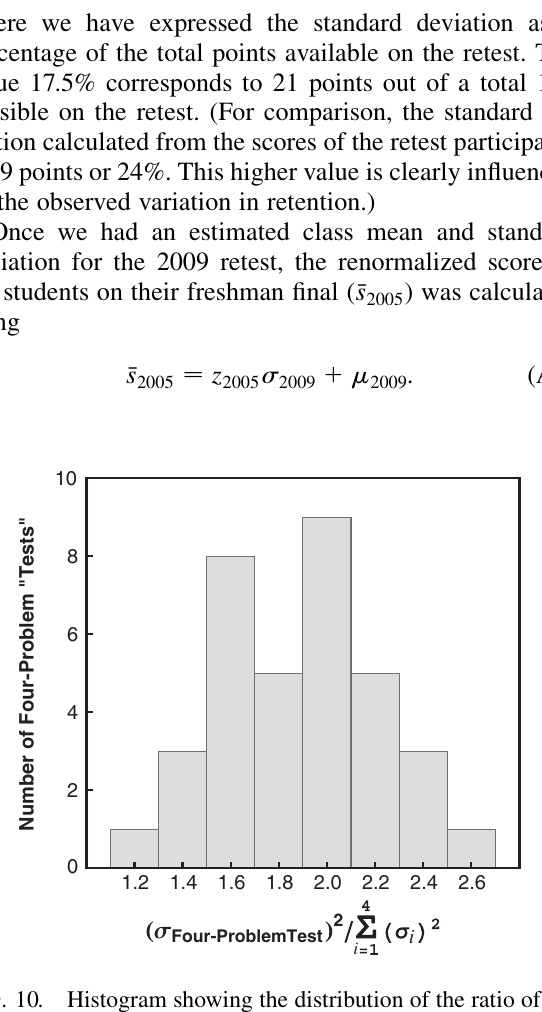
FIG. 10. Histogram showing the distribution of the ratio of the square of the standard deviation observed in 35 four-problem ‘‘tests’’ (combinations of four MIT final exam problems) to the sum of the squared standard deviations of the four individual